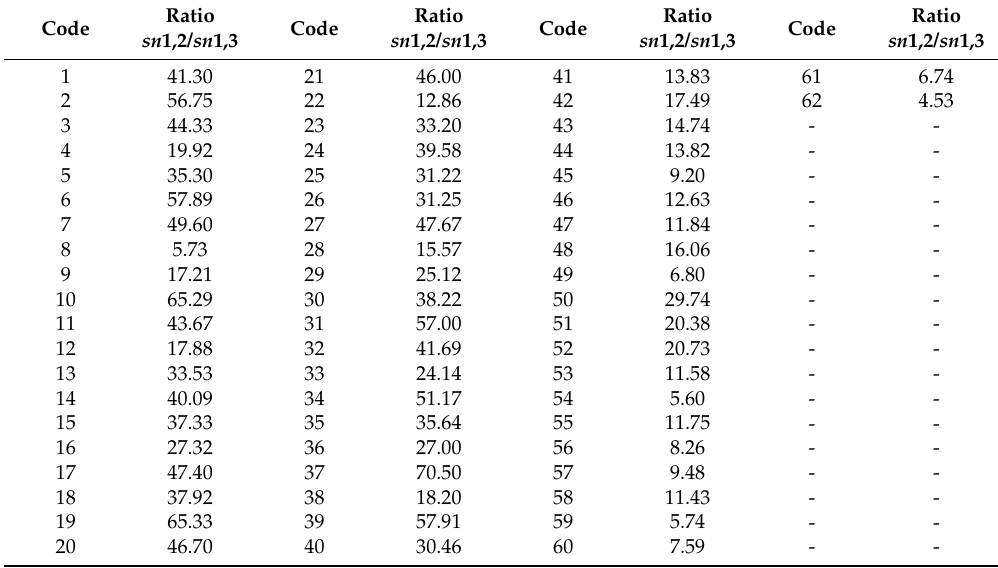
Table 3. The sn -1,2/ sn -1,3 diglycerides ratio obtained from 1 H-NMR normalized signal intensities.